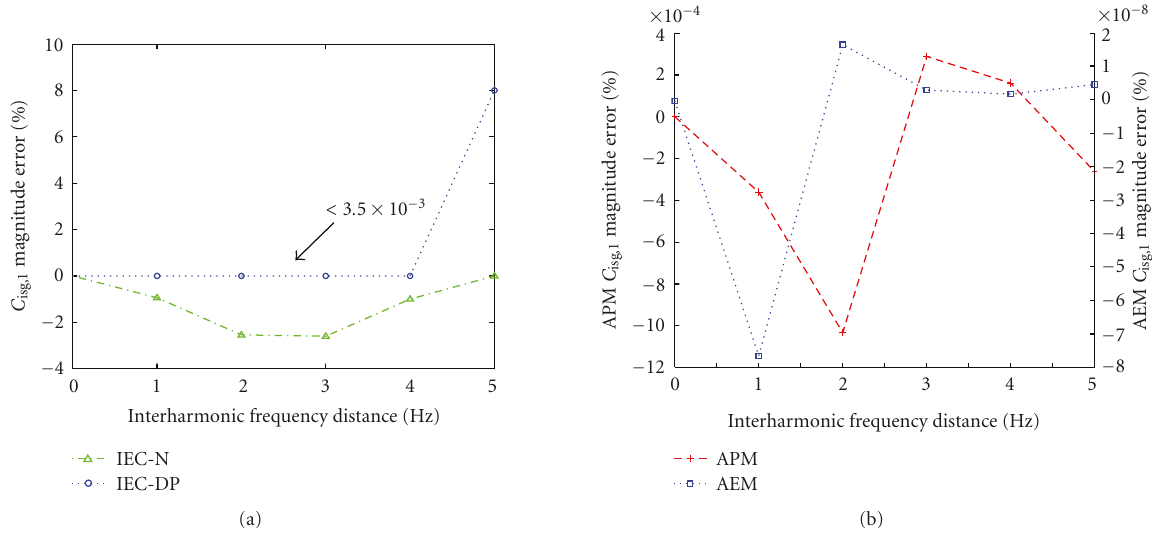
Figure 11: Case study 3: interharmonic subgroup C isg,1 magnitude error (in %) versus the distance of interharmonic tones from 75Hz with smoothed results over 15 intervals of 200milliseconds: (a) IEC-N (- · - Δ ) and IEC-DP (dotted line ◦ ), (b) APM (dotted line +) and AEM (dotted line (cid:3)